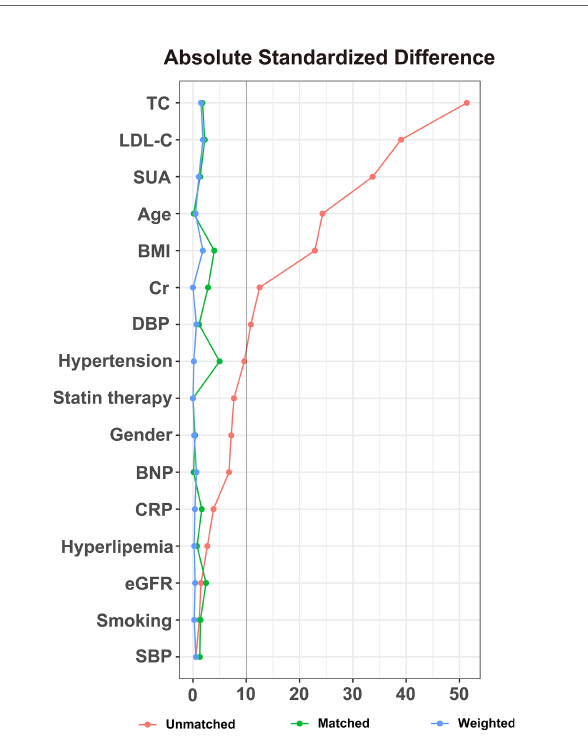
FIGURE 4 | Absolute standardized differences in unweighted and propensity score-weighted data sensitivity analyses. TC, total cholesterol; LDL-C, low- density lipoprotein cholesterol; SUA, serum uric acid; BMI, body mass index; Cr, creatinine; DBP, diastolic blood pressure; BNP, brain natriuretic peptide; CRP, C-reactive protein; eGFR, estimated glomerular fi ltration rate; SBP, systolic blood